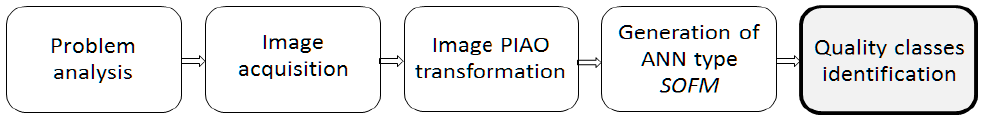
Figure 5. The pattern of creation of a Self-Organising Feature Map (SOFM) neural classifier .